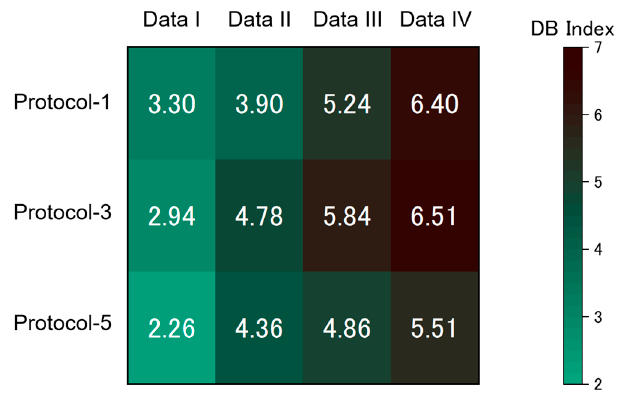
Figure 8. Colormap of Davies–Bouldin (DB) indices for the TFRs datasets.